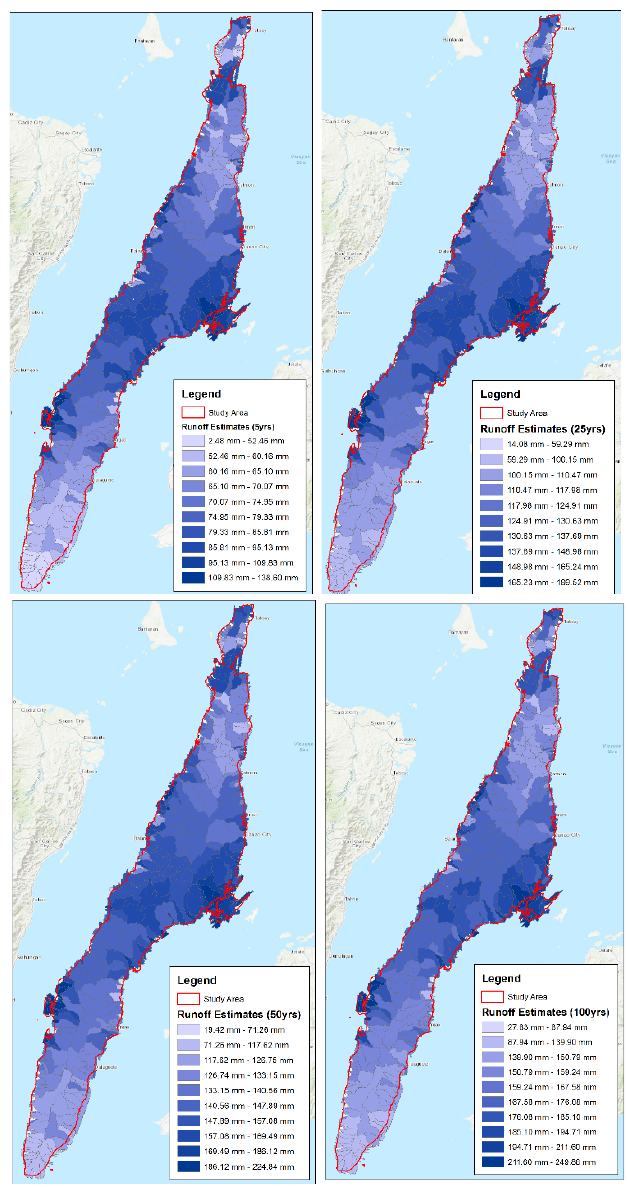
Figure 6. Runoff estimates for the 5-year, 25-year, 50-year and 100-year return periods